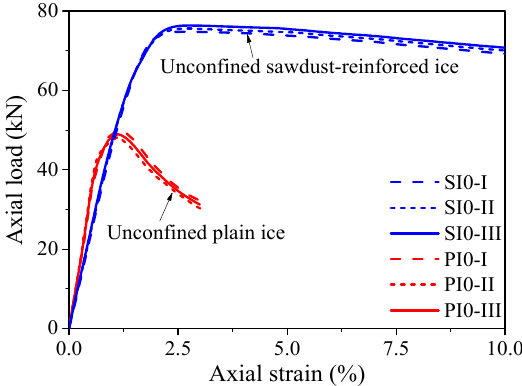
Figure 7. Axial load vs. strain responses of the plain ice and sawdust reinforced ice columns.